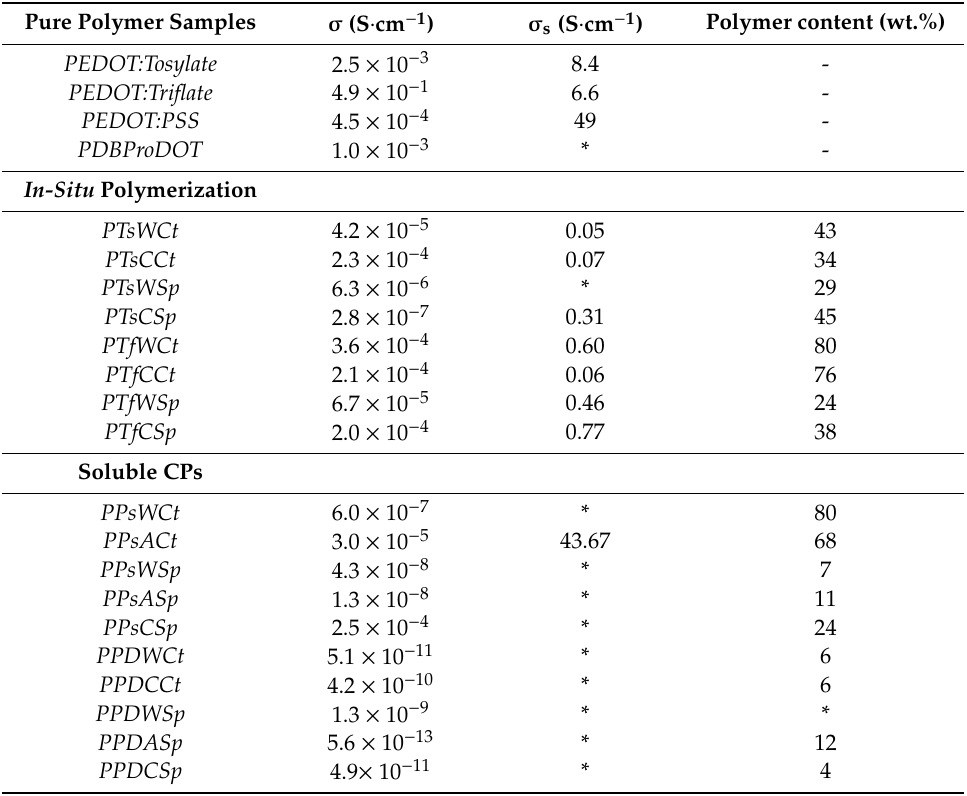
Table 3. Electrical conductivity of CPs and composite materials. Pure Polymer